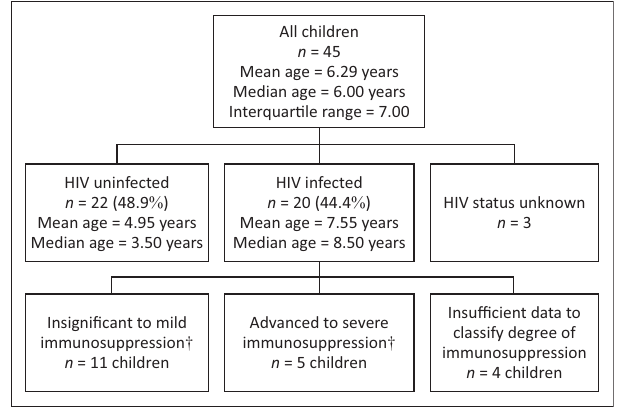
All children n = 45 Mean age = 6.29 years Median age = 6.00 years Interquar(cid:4)le range = 7.00